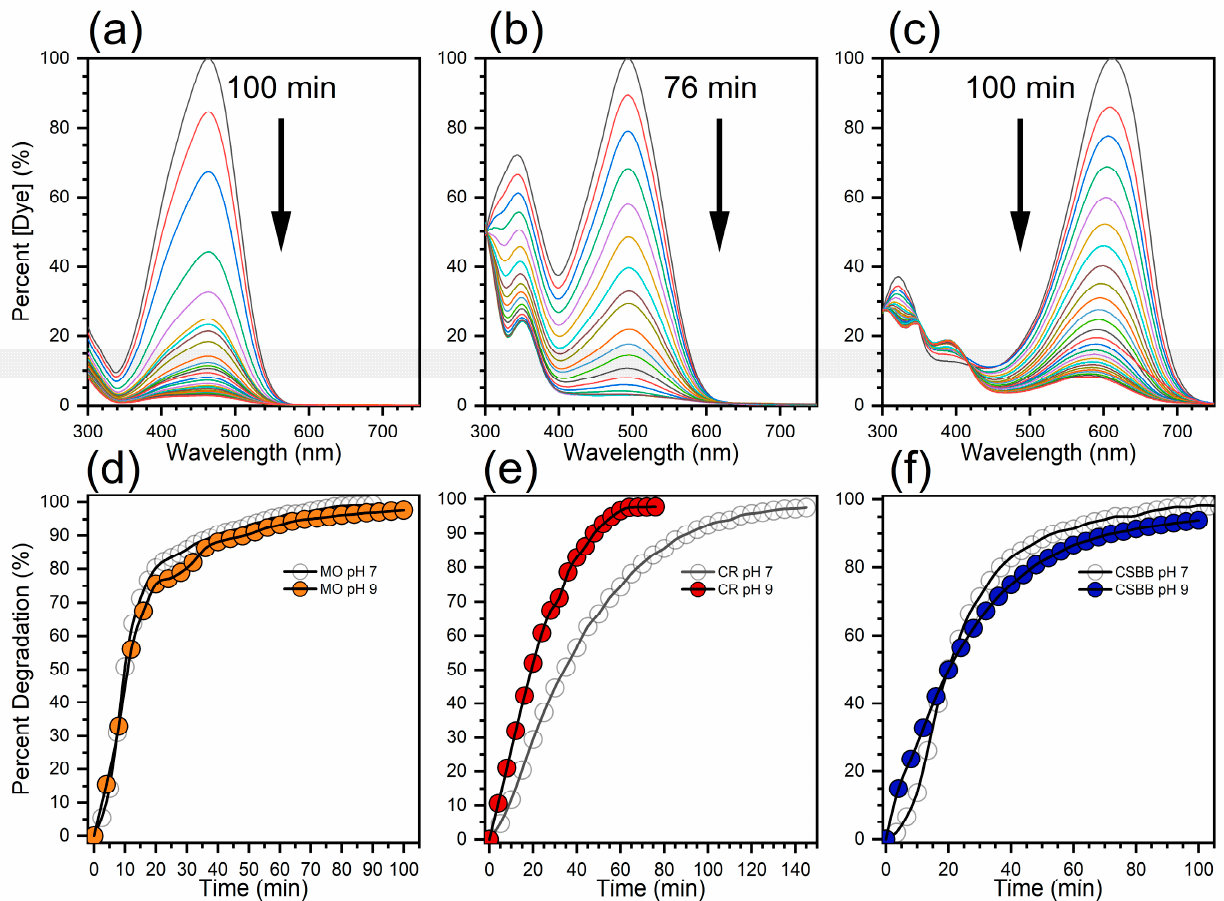
Figure 6. ( a – c ) UV/vis spectra of percentage dye concentration remaining, and ( d – f ) time plots of percentage dye degradation for the catalytic reduction of MO, CR, and CSBB, respectively, by NaBH 4 in the presence of 200 mg Ag NP–cotton at pH 9.